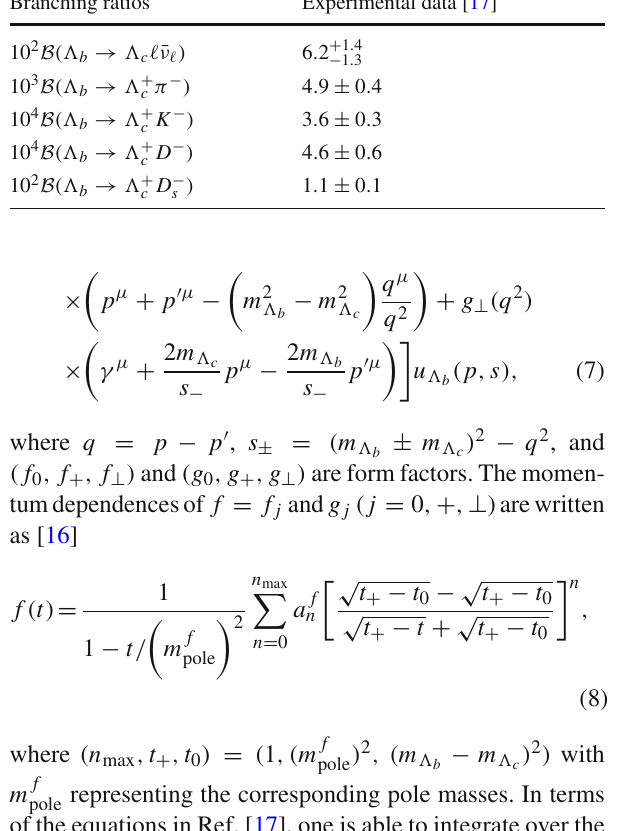
Table 1 Inputs of the experimental data Branching ratios Experimental data